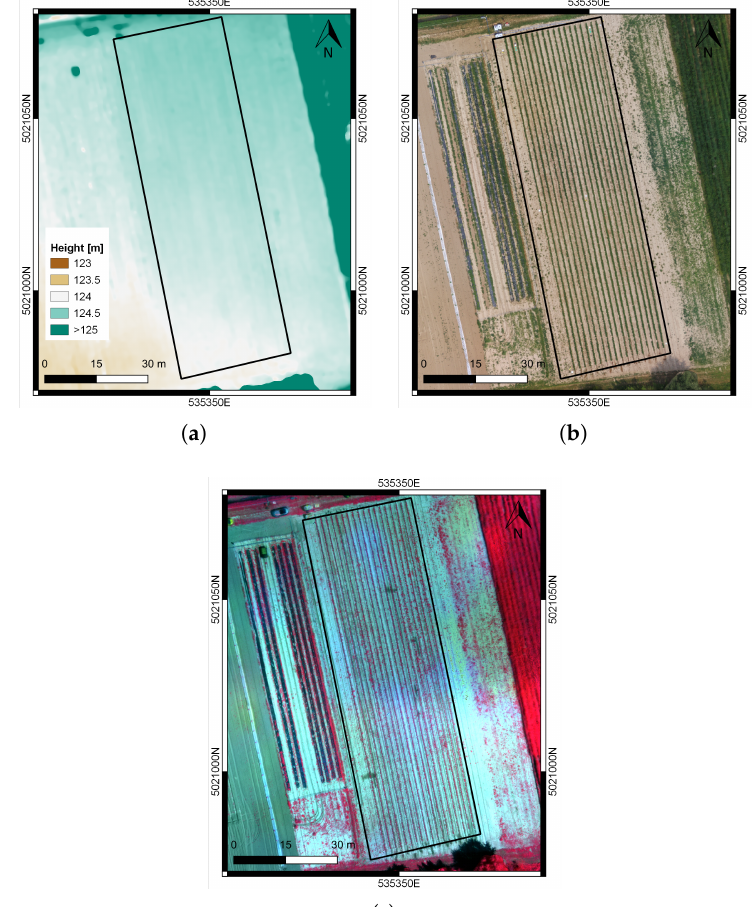
Figure 7. Tomato site: DSM ( a ) and orthophoto ( b ) produced through photogrammetric processing of RGB dataset; false color orthophoto ( c ), generated from the multispectral